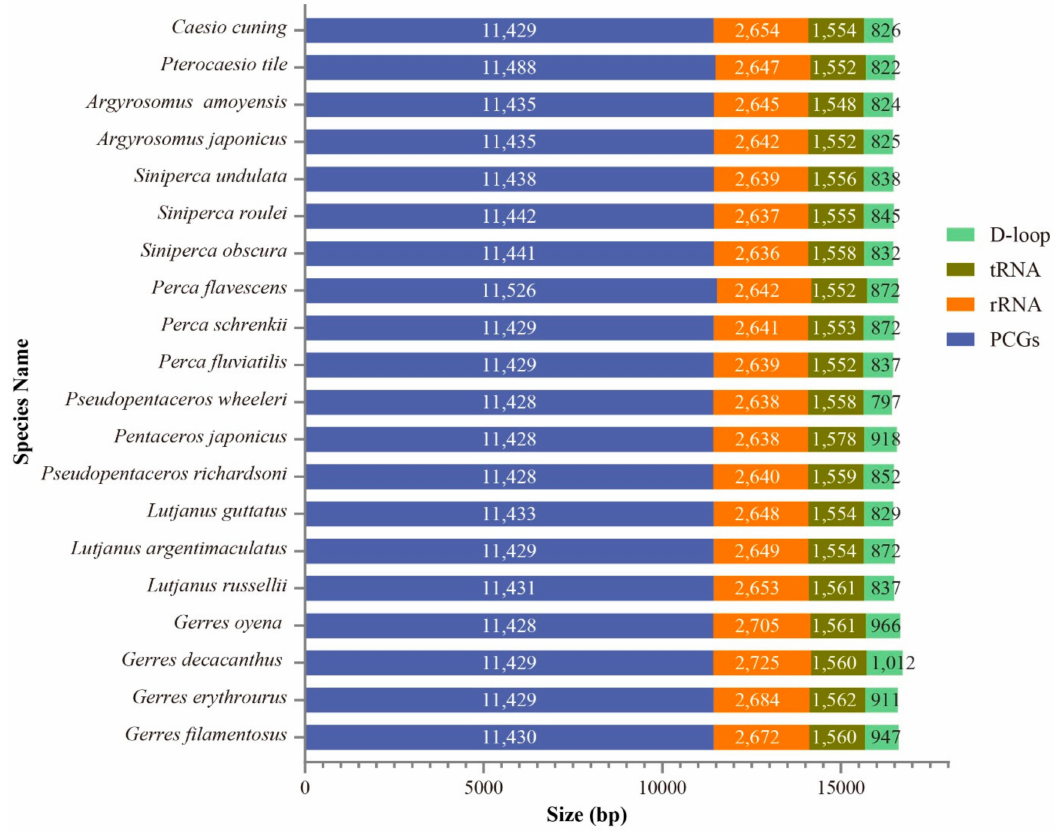
Figure 2. The length of protein-coding genes (PCGs), tRNAs, rRNAs, and control regions among 21 Perciformes